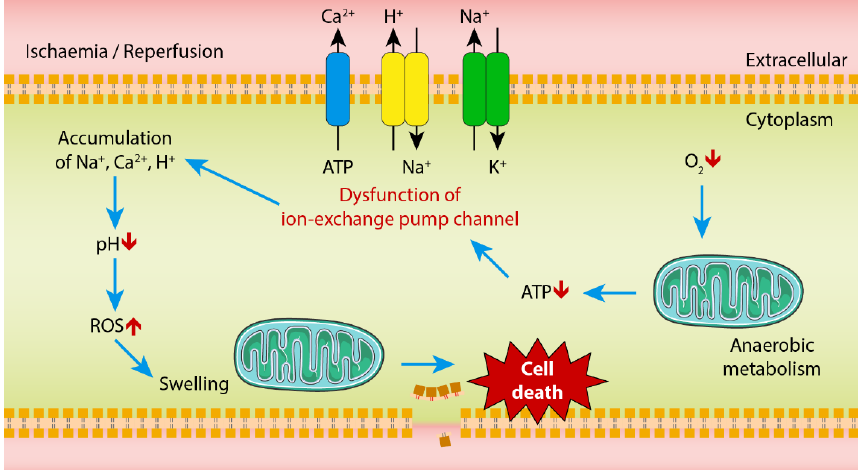
Figure 1. Overview of the process of ischemia-reperfusion (IR) injury. Upon depletion of oxygen during the ischaemic stage, mitochondria initiate anaerobic metabolism and ATP production decreases. Further, ion-exchange pump channel dysfunction and pH level decreases leading to cell swelling. During the reperfusion stage, mitochondrial swelling and accumulation of H + , Na + and K + result in oxidative stress leading to the excessive production of ROS. This induces cell injury, leading to cell death. The figure is modified from Reference [48] .